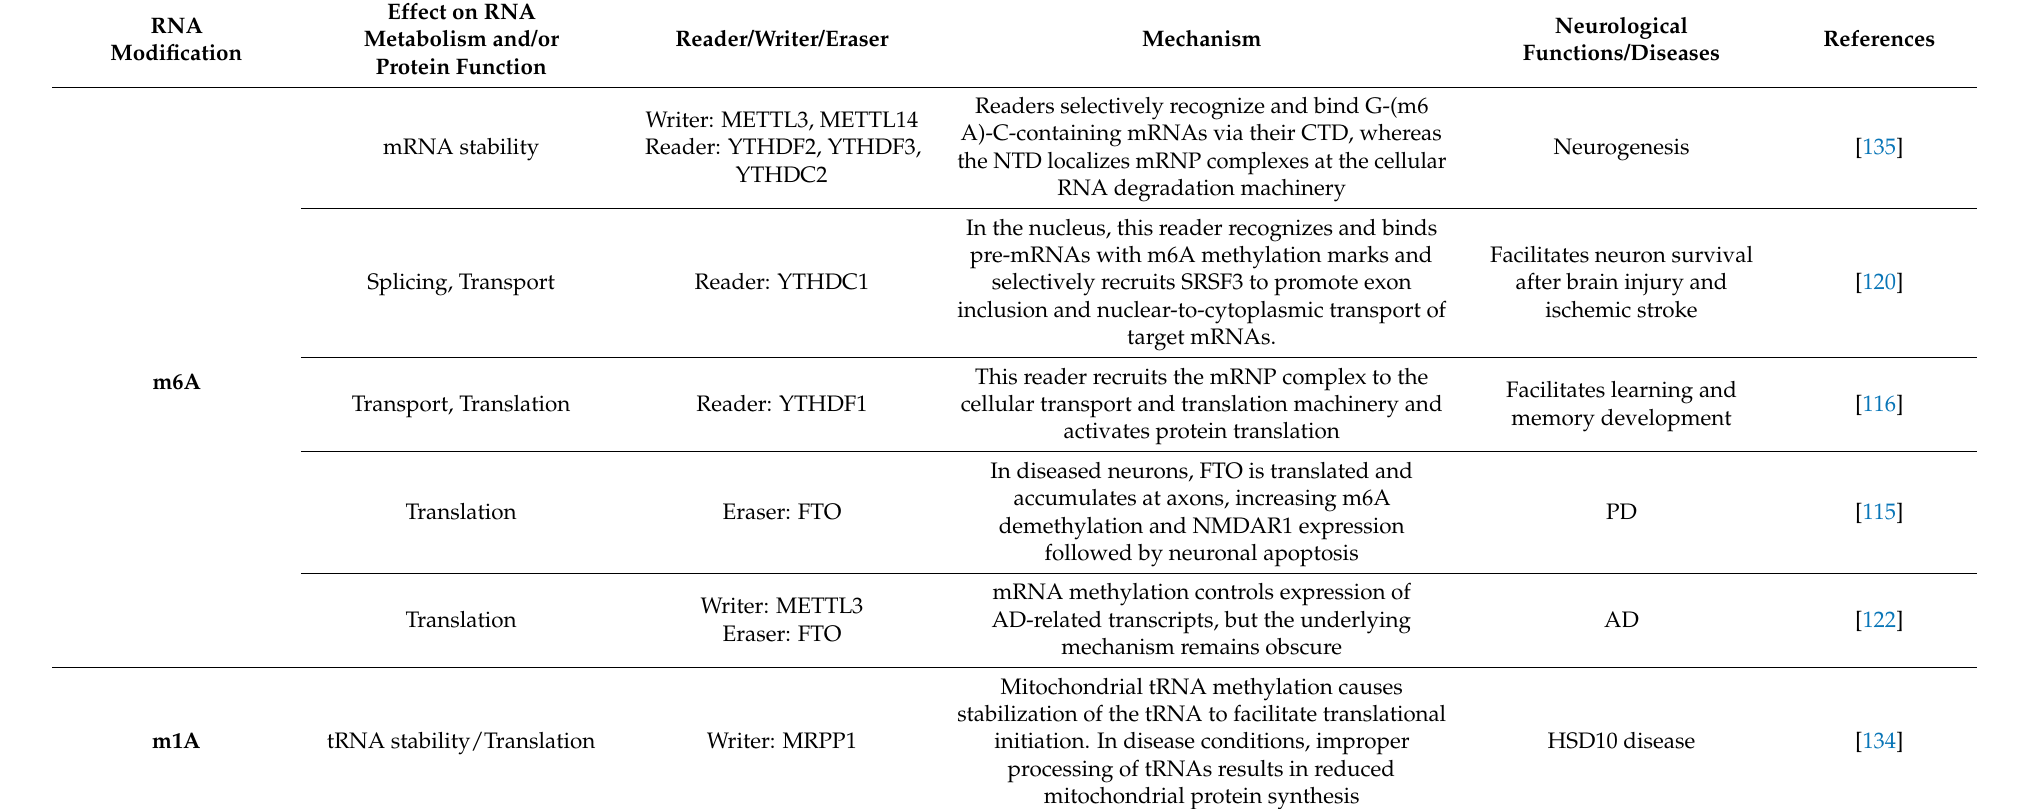
Table 2. Effects of RNA modifications on various RNA metabolic processes and their association with neurological functions and